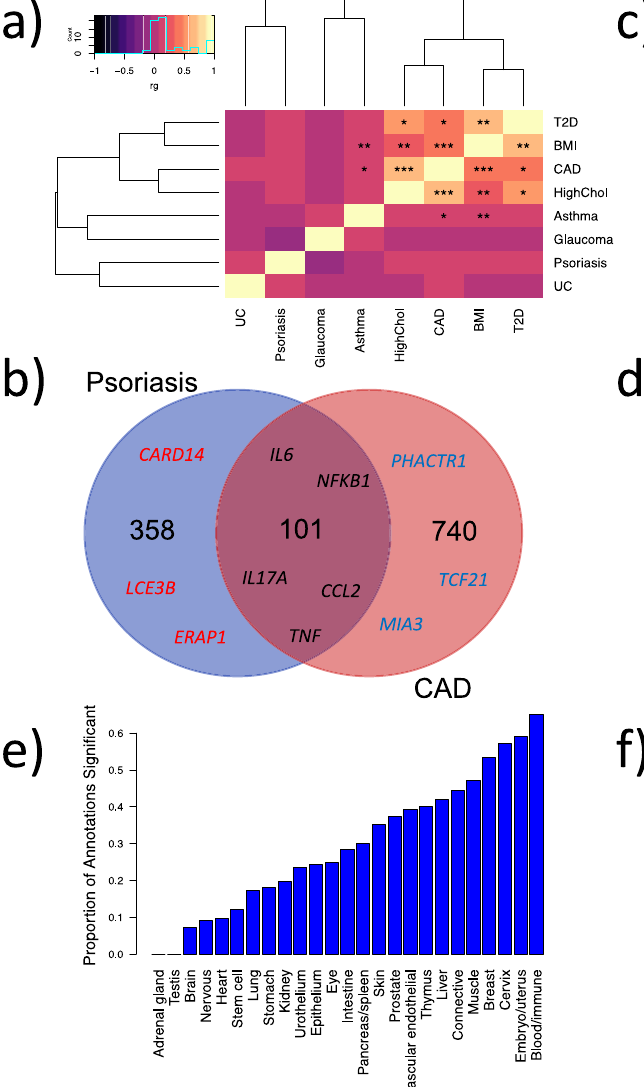
are highlighted in red. d Manhattanplot of opposing (opposite direction of effect) psoriasis/CAD TDMA signals, showing markers that are more signi fi cant in TDMA than for either trait. The locus we identi fi ed as suggestive signi fi cant ( p <1×10 − 4 ) for both traits (meeting all our criteria) are highlighted in blue. e Bar plot of the proportion of annotations, from GARFIELD enrichment analysis on TDMA outside the MHC, that are signi fi cant in each category. Notably, the Blood/Immune cate- gory has highest proportion of signi fi cant annotations, demonstrating an immu- nological basis for the shared genetics between psoriasis and CAD. f Grouped bar plot indicating the number of markers in 95% Bayesian credible intervals (BCI) calculated for psoriasis, CAD and TDMA at each locus. TDMA reduces the number of markers in the BCI for all for loci compared to either trait, thus facilitating improved fi